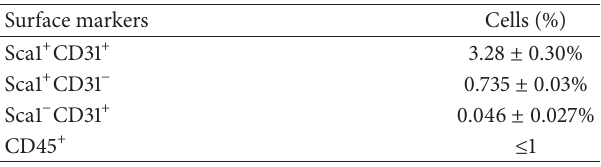
Table 1: Surface markers expressed on the whole adult mouse heart